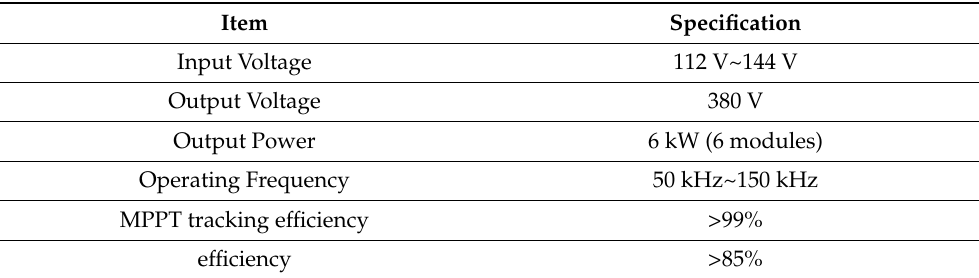
Table 5. The specification of LLC DC/DC